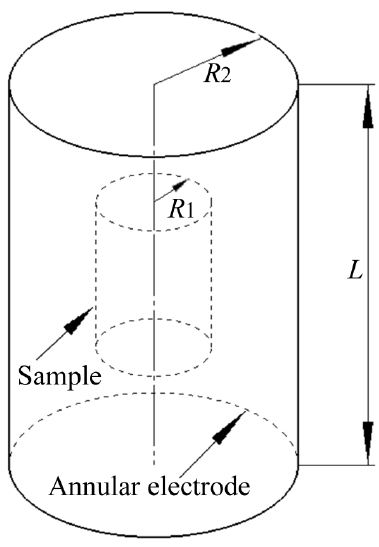
Figure 3. Schematic diagram of the sample and electrode.